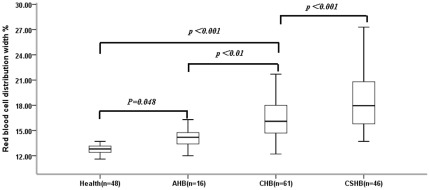
The association between red cell distribution width (RDW) values and different disease states in HBV-infected patients.Data are expressed as box plots, in which the horizontal lines illustrate the 25th, 50th, and 75th percentiles of the values of RDW. The vertical lines represent the 5th and 95th percentiles. AHB, Acute hepatitis B; CHB, Chronic hepatitis B; CSHB, Chronic severe hepatitis B.